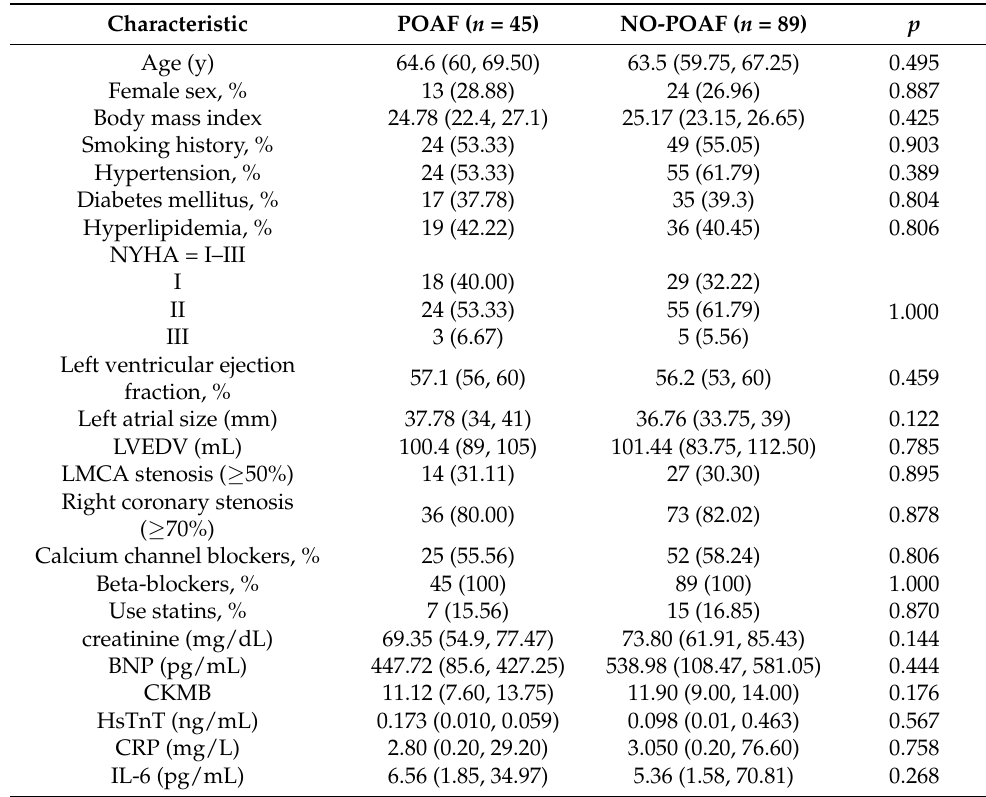
Table 1. Demographic and clinical characteristics of the patients at